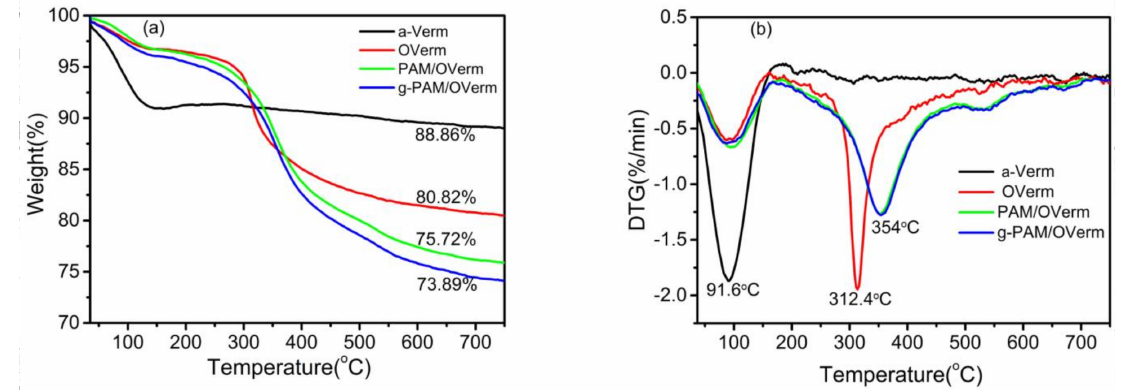
Figure 8. ( a ) TG and ( b ) DTG curves of a-Verm, OVerm, PAM/OVerm and g-PAM/OVerm.